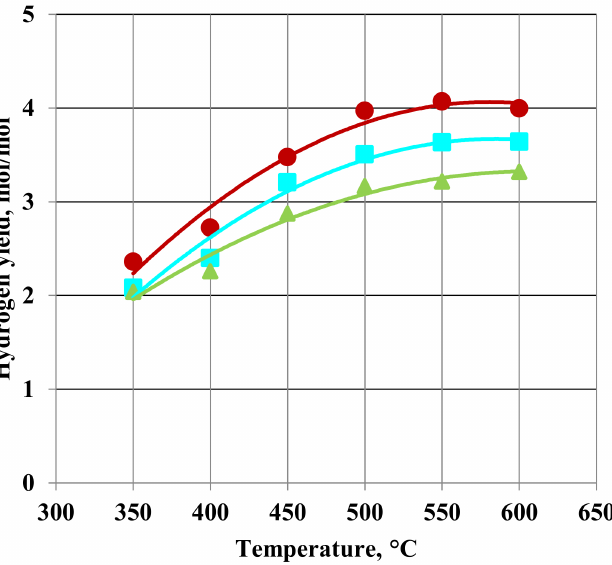
Figure 7. The influence of temperature and feed flow rate on hydrogen yield. Water to ethanol molar ratio in the feed = 3. Feed flow rate: • = 0.4, (cid:4) = 0.8, and (cid:78) = 1.2